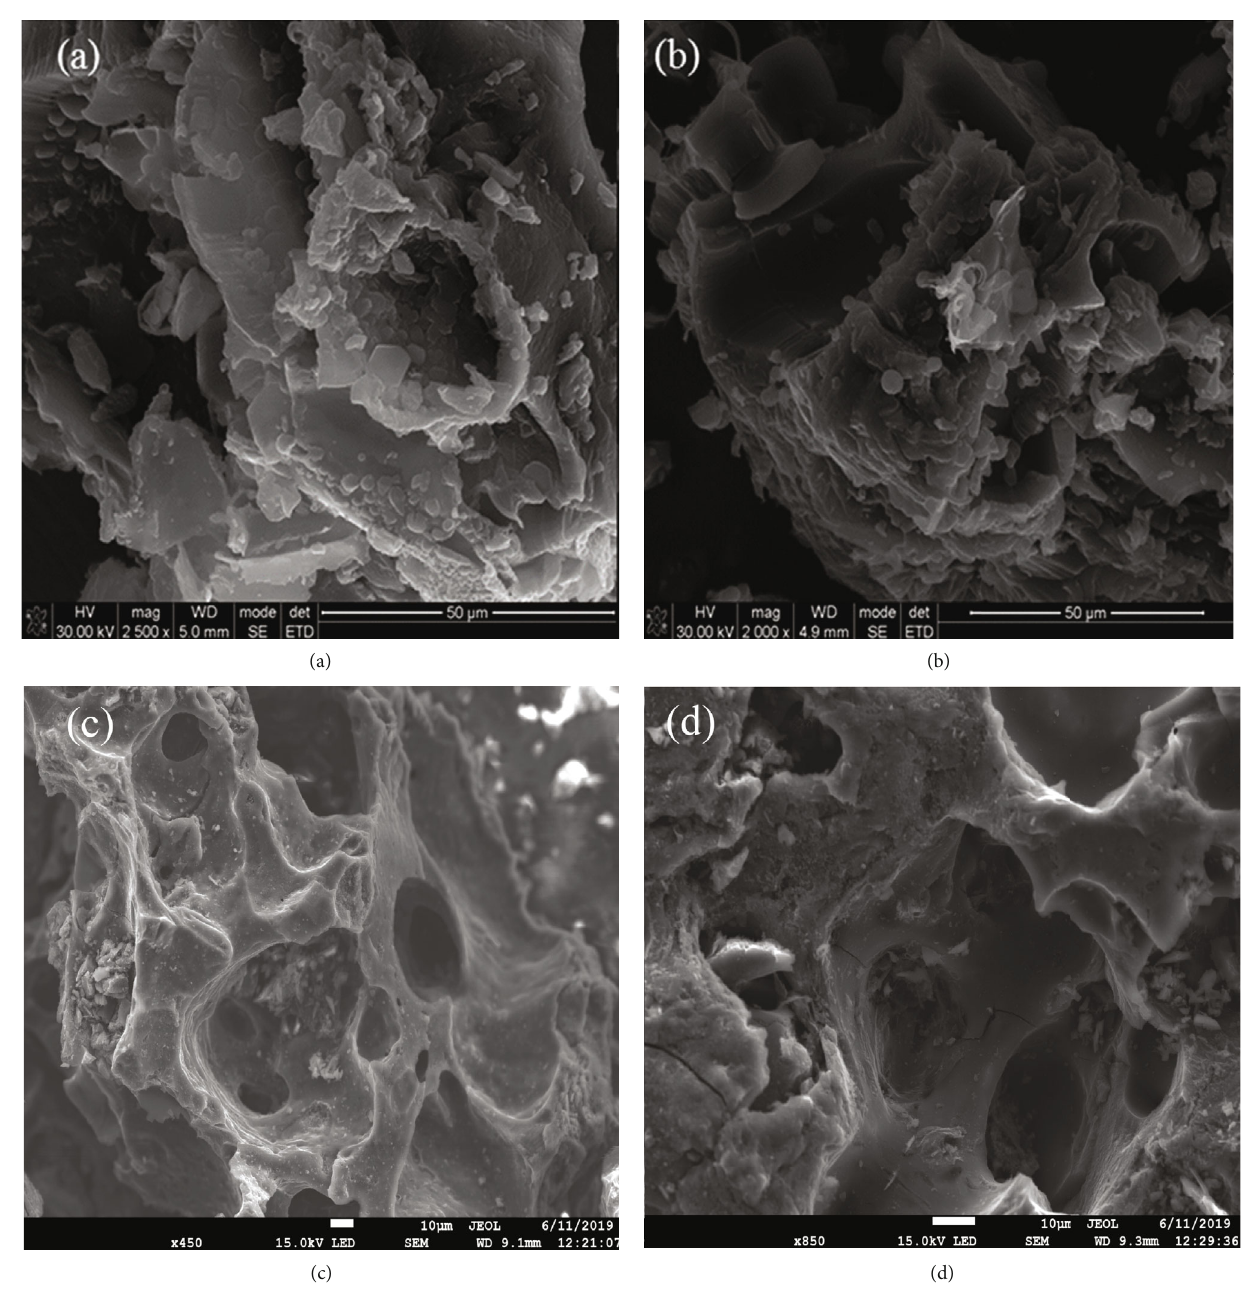
Figure 3: FESEM: (a, c) RH-AC and (b, d)